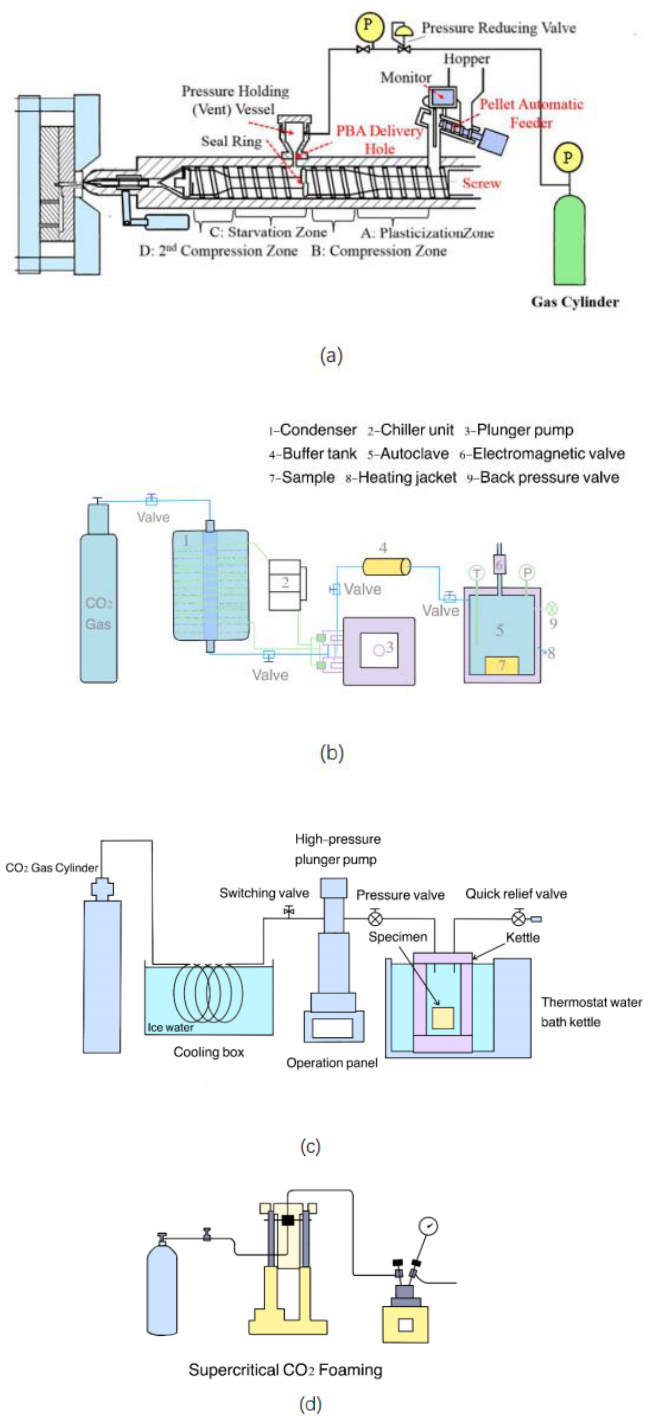
Figure 5. Related experimental flow chart: ( a ) RIC‑FIM Technology. Adapted with permission from Ref. [15]. Copyright © 2017, American Chemical Society; ( b ) Supercritical foam combined with radiation crosslinking. Adapted with permission from Ref. [44]. Copyright © 2017, Wiley Periodicals, Inc.; ( c ) Supercritical foaming combined with particle leaching. Adapted with permission from Ref.